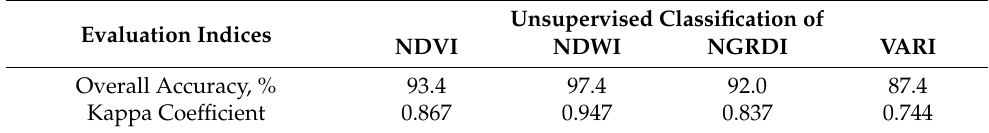
Table 2. Accuracy assessment of unsupervised index classification.